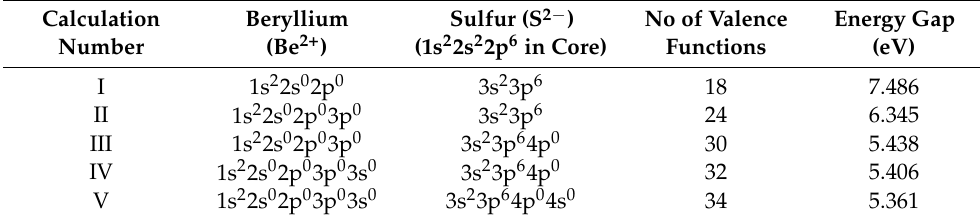
Table 2. The successive, self-consistent calculations for zinc-blende beryllium sulfide, using the BZW-EF computational approach. We performed our calculation utilizing the experimental lattice constant of 4.86 Å.